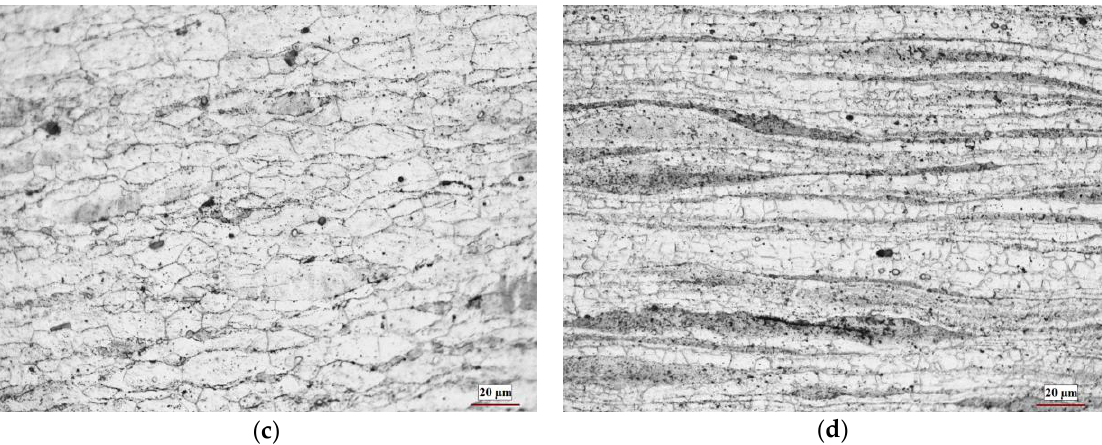
Figure 8. Optical microstructures of the ND specimens deformed at conditions correspond to peak-efficiency conditions of the four domains in the ND processing map (Figure 4b), indicating the occurrence of DRX. The compression axis (ND direction) is vertical. (a) 300 ◦ C and 0.0003 s − 1 (Domain 1); ( b ) 400 ◦ C and 0.0003 s − 1 (Domain 2); ( c ) 500 ◦ C and 0.0003 s − 1 (Domain 3); ( d ) 300 ◦ C and 10 s − 1 (Domain 4).